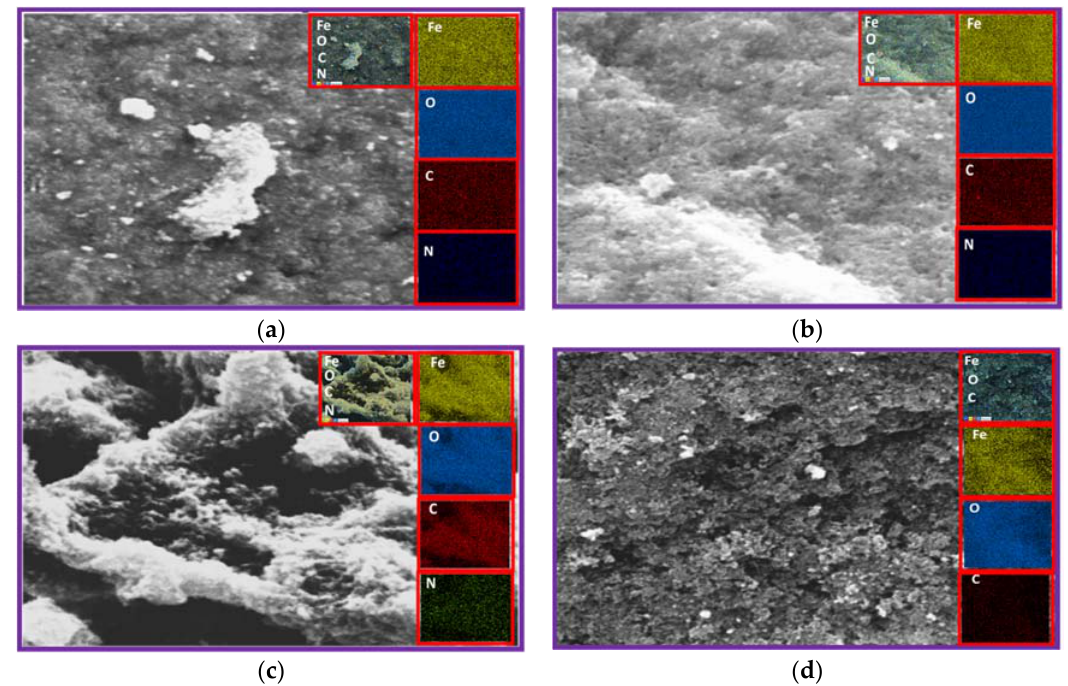
Figure 7. FESEM image ( a ) IONP@GA1 (inset: EDX elemental map of Fe, O, C, and N); ( b ) IONP@GA2 (inset: EDX elemental map of Fe, O, C, and N); ( c ) IONP@GA3 (inset: EDX elemental map of Fe, O, C, and N); and ( d ) IONP (inset: EDX elemental map of Fe, O, C).